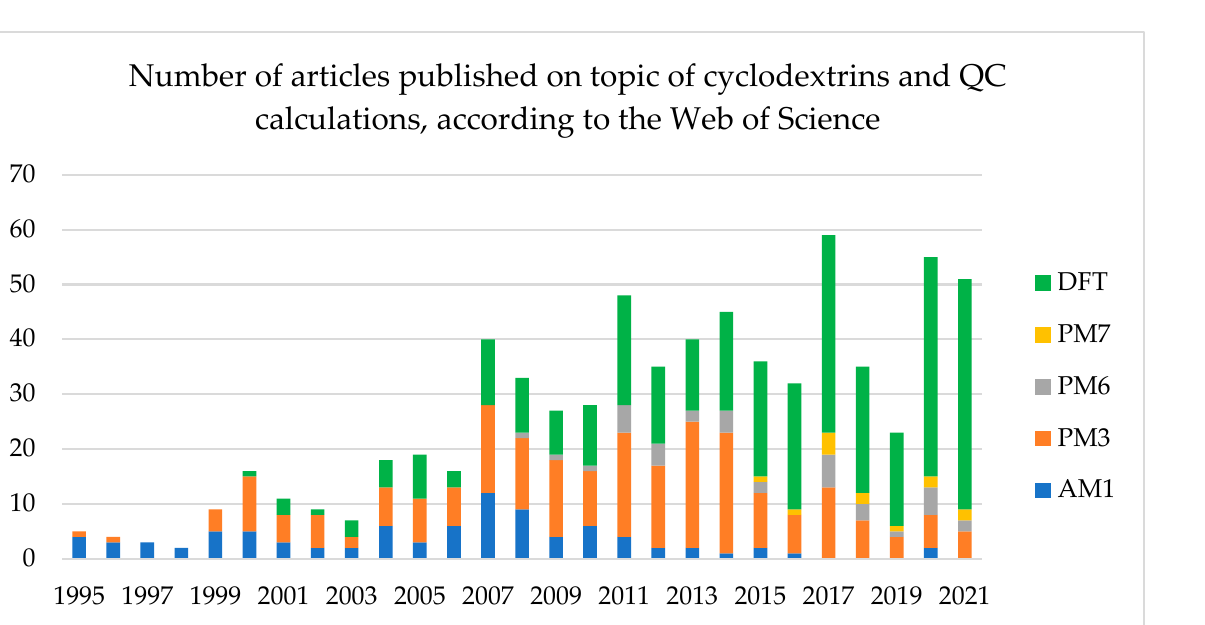
Figure 2. Changes in the number of articles published on the topic of cyclodextrin and either different semi-empirical or DFT methods over the years.